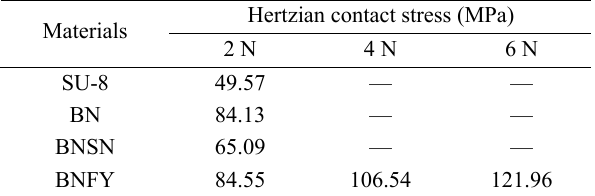
Table 2 Hertzian contact stress (MPa) for the static contact between the 4 mm diameter silicon nitride ball and coated materials.